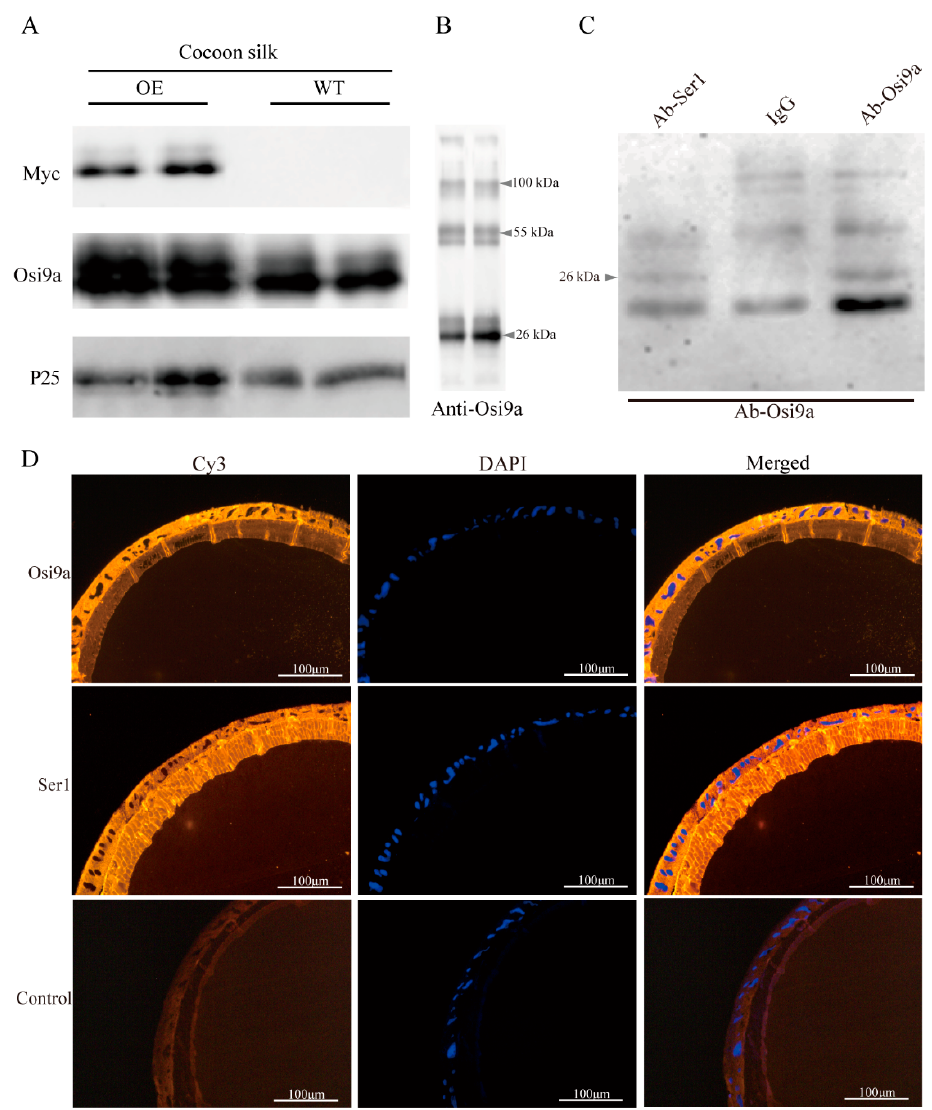
Figure 3. Interaction between BmOsirsi9a and Ser1. ( A ). Western blotting of BmOsi9a and Myc-tag in the cocoon silks of the OE and WT, using P25 as a control. Proteins dissolved from the cocoon were separated by SDS-PAGE and immunoblotted with anti-BmOsi9a, anti-Myc, and anti-P25 antibodies. ( B ). Western blotting of BmOsi9a in the cocoon silks. Two high-molecular-weight bands (55 and 100 kDa) contained the Ser1 protein, as determined by LC-MS/MS analysis. The two lanes are twice biological replicates. ( C ). Co-IP analysis of BmOsi9a and Ser1. Lane 1: proteins of the MSG incubated with anti-Ser1 antibody; Lane 2: proteins of the MSG incubated with rabbit IgG; Lane 3: proteins of the MSG incubated with anti-BmOsi9a antibody. ( D ). Immunofluorescence of BmOsi9a and Ser1 in the MSG. Sections were prepared from the MSG and observed under ultraviolet light for DAPI and green light for CY3.